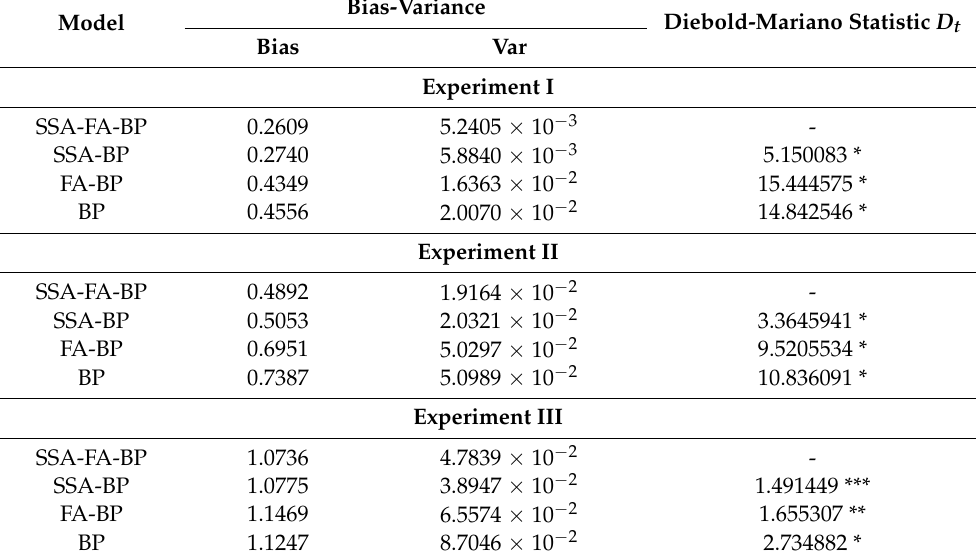
Table 10. Bias-variance and Diebold-Mariano test of three experiments among the four different models for the average value of four quarters and three